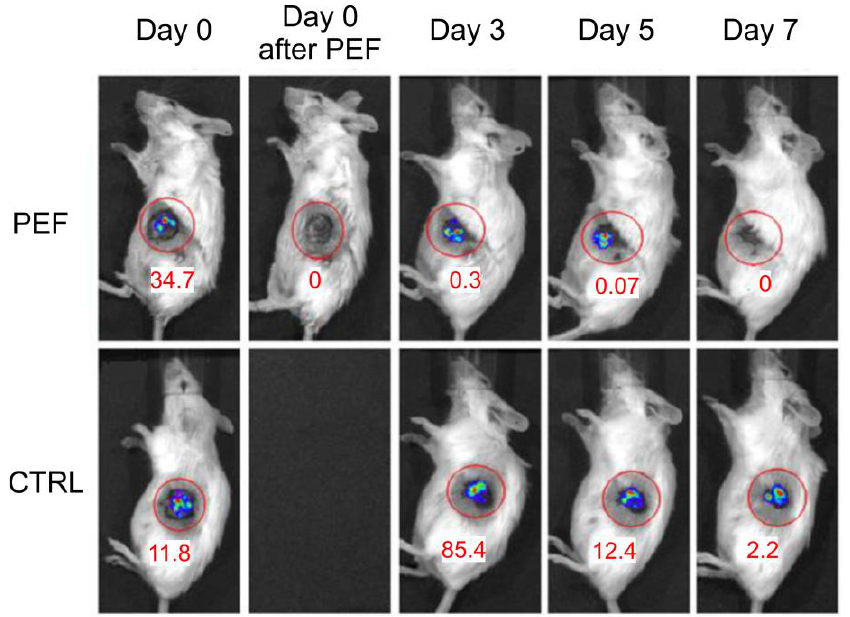
Figure 5. The mice with only the AA (1%) treatment (CTRL) and the mice treated with PEF (3 kV voltage is applied between 1.2 mm gap electrodes) + 1% AA treatment. Red circle indicates region of interest (ROI) where the luminescence signal was quantified. The number indicates the intensity of luminescence in the ROI.